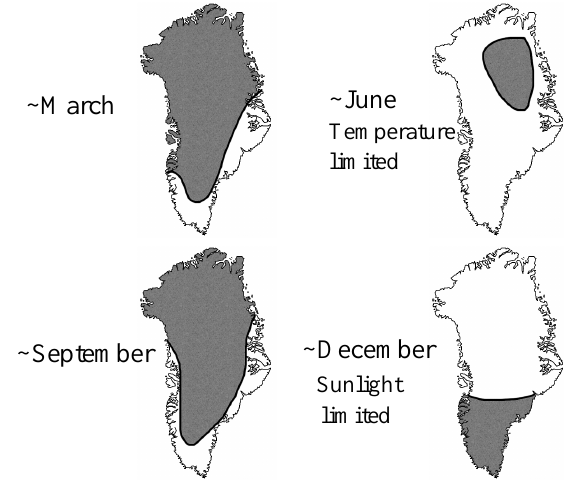
Fig. 11. Seasonal plots of the area of the Greenland ice cap where solar elevation exceeds 5 degree and where the average daily low temperature is < − 15 ◦ C (shaded). These shaded areas represent the locations where we would expect RGM production and deposi-